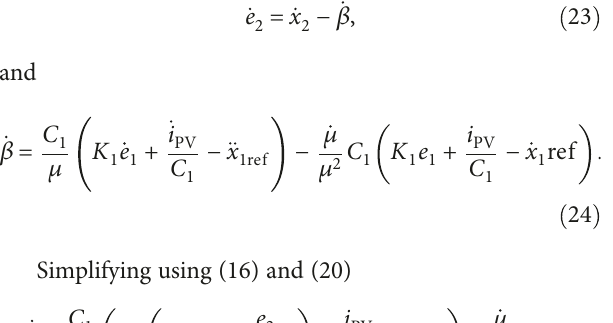
Table 2: Parameters of controller and